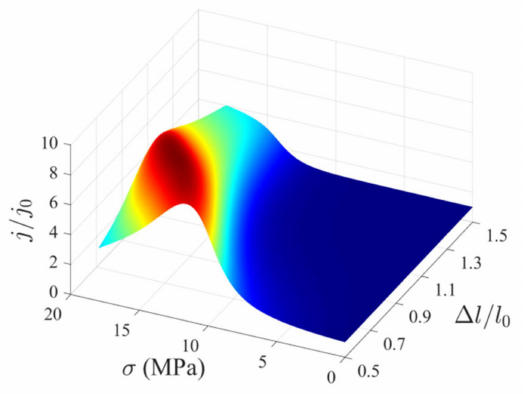
Figure 5. Variations in the output current at the PN junction with the variations in the height and width of tensile-mode MIAPB when L A / l 0 =